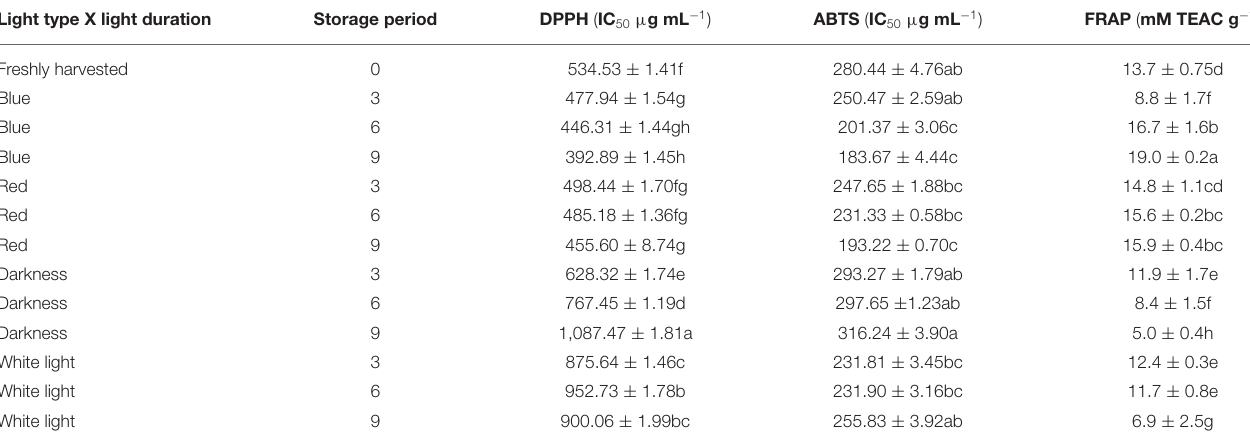
TABLE 2 | The influence of red and blue LED lights on the antioxidant properties of coriander leaves during post-harvest storage for 3–9 days. Light type X light